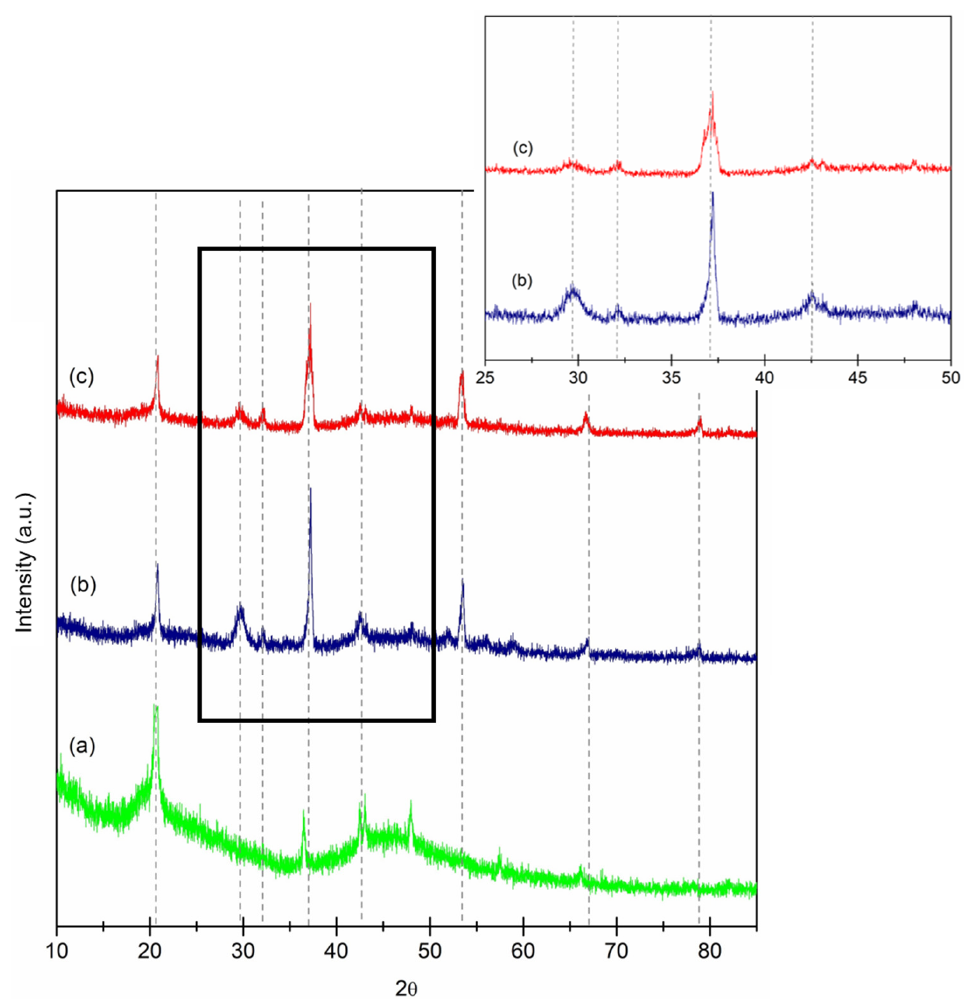
Figure 2. XRD of CA ( a ), CA7dSrP ( b ), and CA14dSrP ( c ).